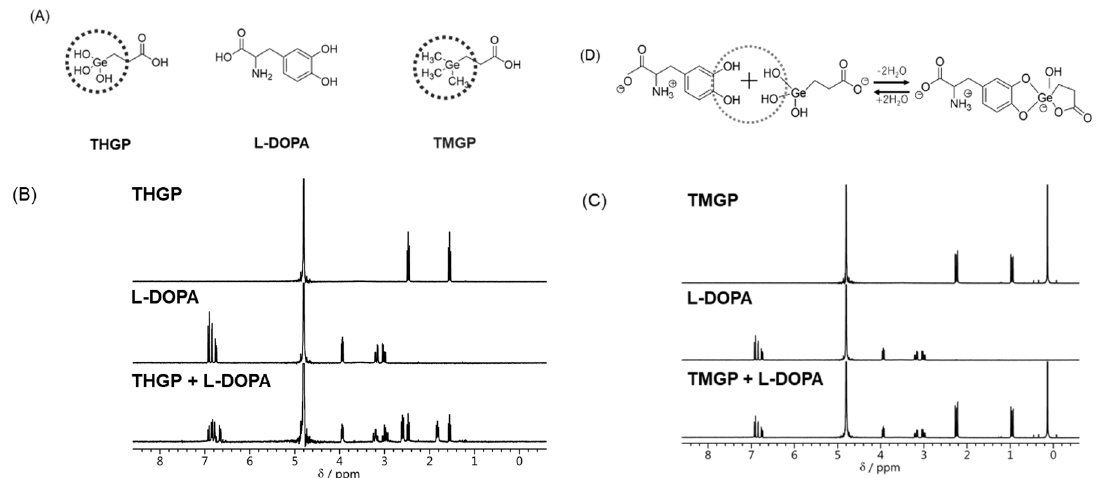
Figure 1. Formation of a complex of L-3,4-dihydroxyphenylalanine (L-DOPA) and 3-(trihydroxygermyl)propanoic acid (THGP). ( A ) Structures of THGP, L-DOPA, and 3-trimethylgermylpropanoic (TMGP). ( B , C ) The formation of a complex between THGP or TMGP and L-DOPA was analyzed by 1 H-NMR (300 MHz). ( D ) Reaction for the formation of the THGP and-L-DOPA